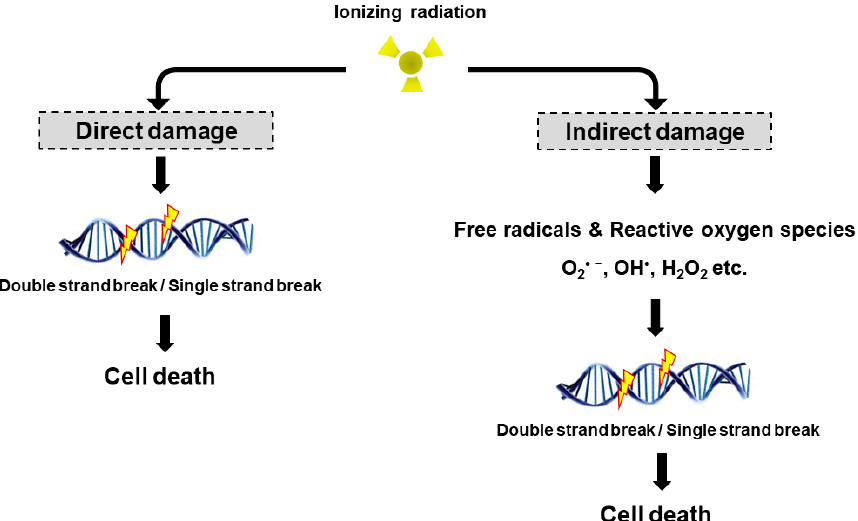
Figure 1. Direct and indirect DNA damage by ionizing radiation. Radiation can directly interact with cellular DNA and cause damage. The indirect DNA damage caused by the free radicals is derived from the ionization or excitation of the water component of the